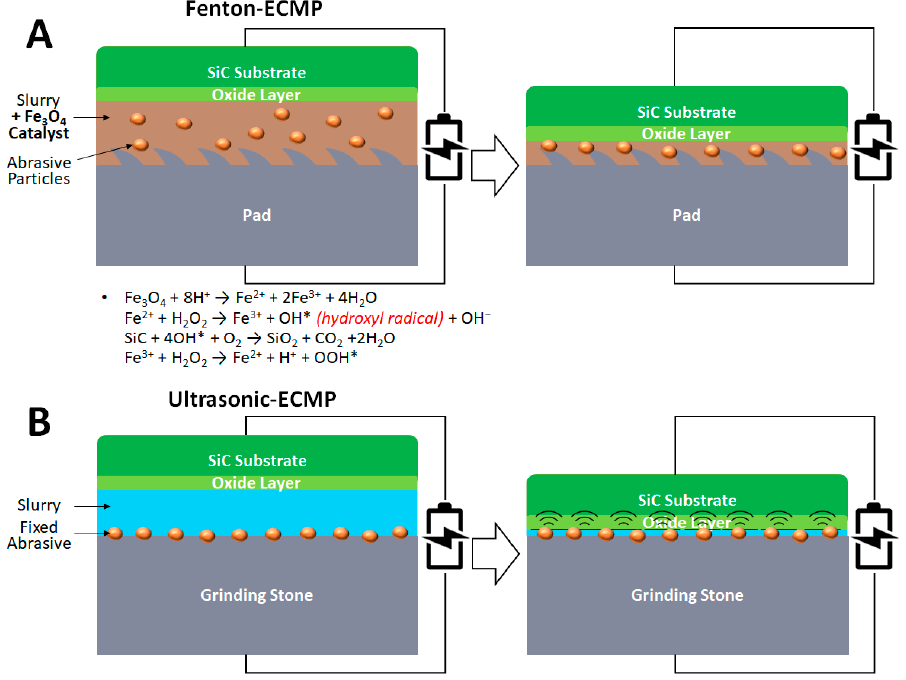
Figure 5. ( A ) Illustration of Fenton-ECMP mechanism. The oxidants and Fe 3 O 4 catalyst in the slurry oxidize the SiC surface into a softer oxide layer which can be removed by the abrasive particles in the slurry and the conditioned CMP pad simultaneously. Under acidic conditions, Fe 3 O 4 generates Fe 2+ which undergoes a Fenton reaction with H 2 O 2 to generate strong oxidant hydroxyl radical, denoted as OH* [27]. The oxide layer is removed by the abrasive particles in the slurry and the conditioned CMP pad simultaneously. ( B ) Illustration of ultrasonic-ECMP mechanism. After the anodic oxidation of SiC, the oxide layer is removed by a vibrating grinding stone with fixed